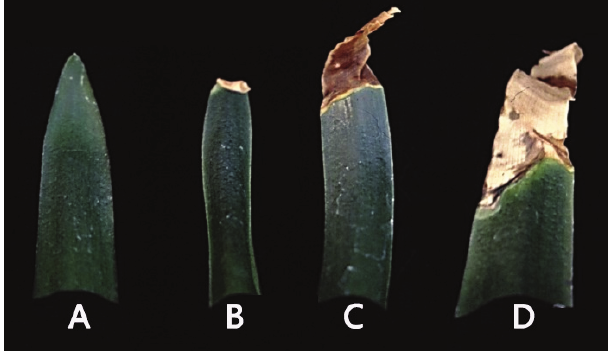
Fig. 1 ­ Various degrees of leaf tip burn (LTB) symptoms in Ornithogalum dubium leaves. Leaf without evident LTB symptom (A) and different degree of LTB symptoms (B, C, and